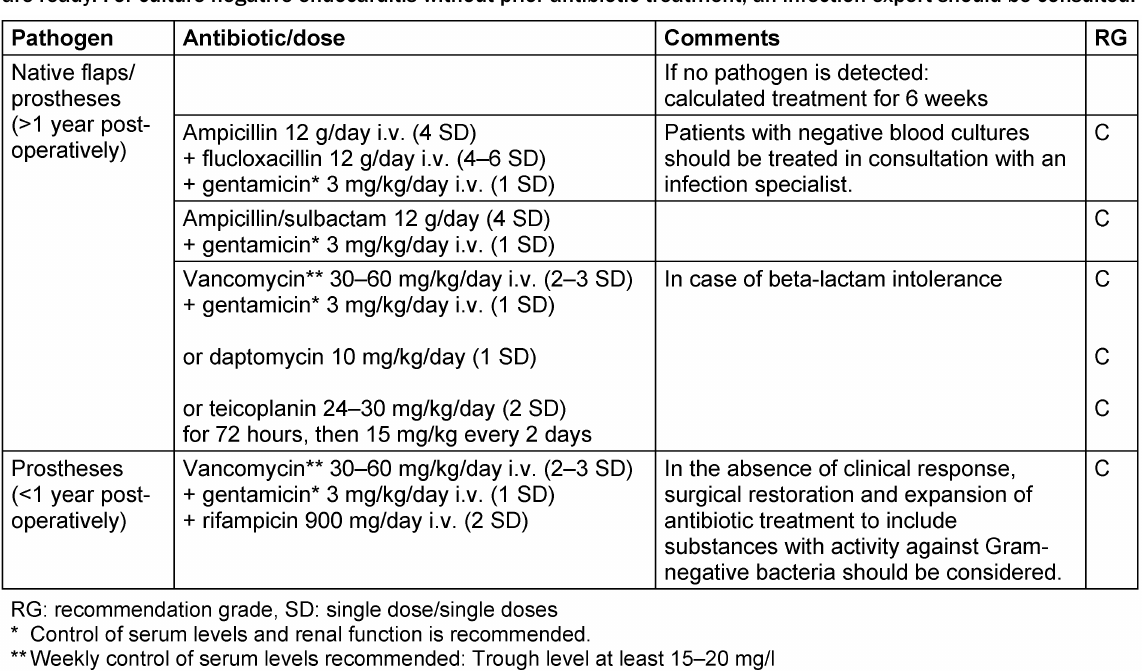
Table 1: Empiric treatment of culture-negative bacterial endocarditis with prior antibiotic treatment or until blood culture